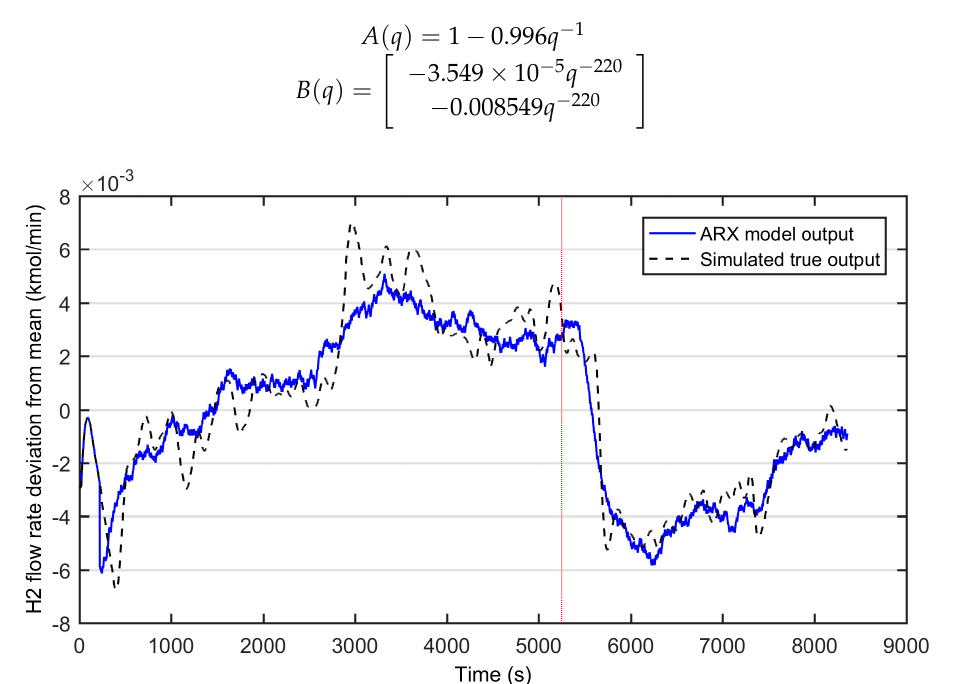
Figure 4. Identification results of the autoregressive model with exogenous input (ARX)-model with two inputs: the water-ethanol ratio and total feed to reformer unit. Solid line: the modeled hydrogen flow rate, dashed line: simulated true output, dotted line: division of training (on right) and testing data (on left).